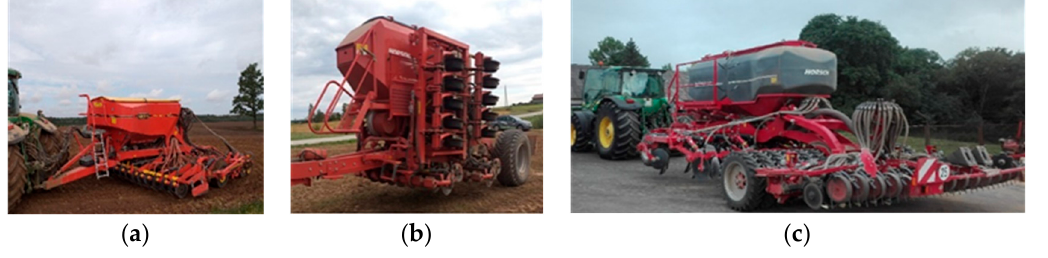
Figure 13. Seed drills for VRS winter wheat seeding: ( a ) Vaderstad Spirit 400C; ( b ) Horsch Focus 6TD; ( c ) Horsch Avatar 6.16 SD.